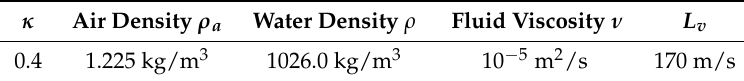
Table 1. Parameter